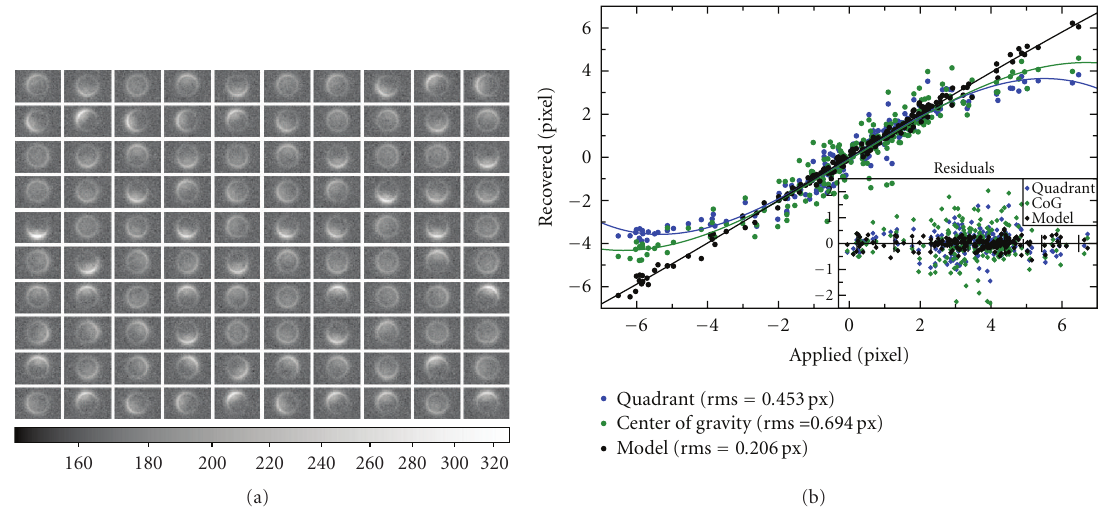
Figure 10: (a) Sequence of artificial images of an R = 8 m star on the fiber viewing Unibrain 520b camera on Stella-II, exposure time set to 1 second. Pixel scale is 0.13 arcsec/pixel the diameter of the pinhole is 2.8arc seconds. The seeing was set to 1arcsec. (b) Recovering of the shift of the center of the star relative to the center of the pinhole, for the image sequence to the left. Center of gravity uses first image moments the quadrant method compares the ADU sum in the left-to-right and up-to-down image segments. These two methods do not deliver a true shift, but only a shift direction. For clarity, the direction has been scaled to match the true o ff set. Direct modeling of the star plus pinhole recovers the true shift and allows to estimate the light loss and seeing, but requires relatively high S/N levels.